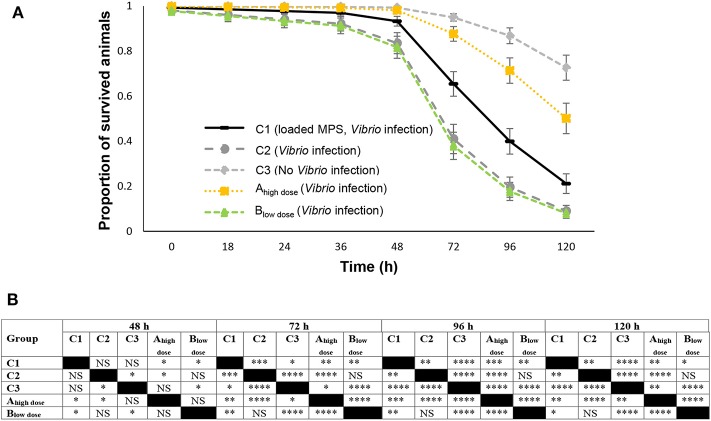
The proportion of surviving European sea bass larvae challenged with V. anguillarum. Animals of group C1 (1.0 mg of empty MPs), C2 (no MPs), Ahigh dose (1.0 mg of DnaK loaded MPs) or Blow dose (0.5 mg of empty MPs and 0.5 mg of DnaK loaded MPs) were challenged with 105 CFU of V. anguillarum. Group C3 received no MPs and was not infected. Survival of the animals was scored before challenge (0 h p.i.) and at several time points p.i. till the end of the trial at 120 h p.i. (A) The proportion of survived animals (mean ± SD) is represented at each time point. (B) Statistical differences in live animals for various groups at different time points after infection with V. anguillarum. For all groups, the proportion of live fish larvae was significantly the same before 48 h p.i. Statistical differences in the proportion of survived animals for various treatment groups, following infection are presented from 48 h p.i. till the end of the experiment at 120 h p.i. An asterisks represents a significant difference between the respective groups [not significant (NS) (P > 0.05), significant *(P < 0.05), significant ** (P < 0.01), significant *** (P < 0.001) and significant ****(P < 0.0001)]. Comparison between a group and itself is marked in black.